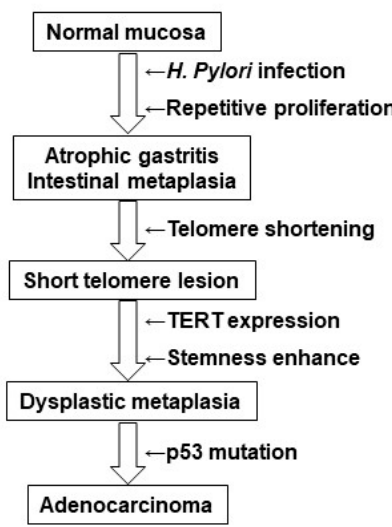
Figure 7. DM in H. pylori -associated gastric carcinogenesis pathway. The position of DM in the H. pylori-associated gastric carcinogenesis pathway is illustrated. See Conclusion section for explanation. DM, dysplastic metaplasia.